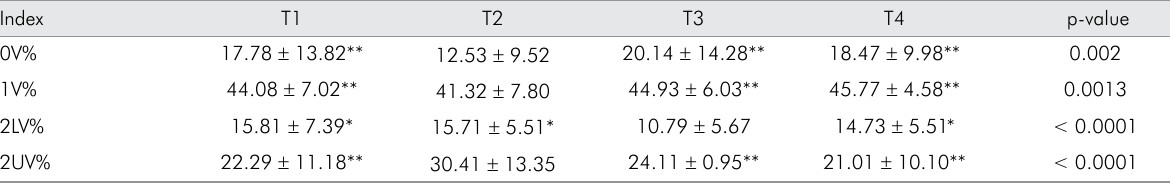
Table 3. Mean and standard deviation of symbolic analysis indexes in T1, T2, T3 and